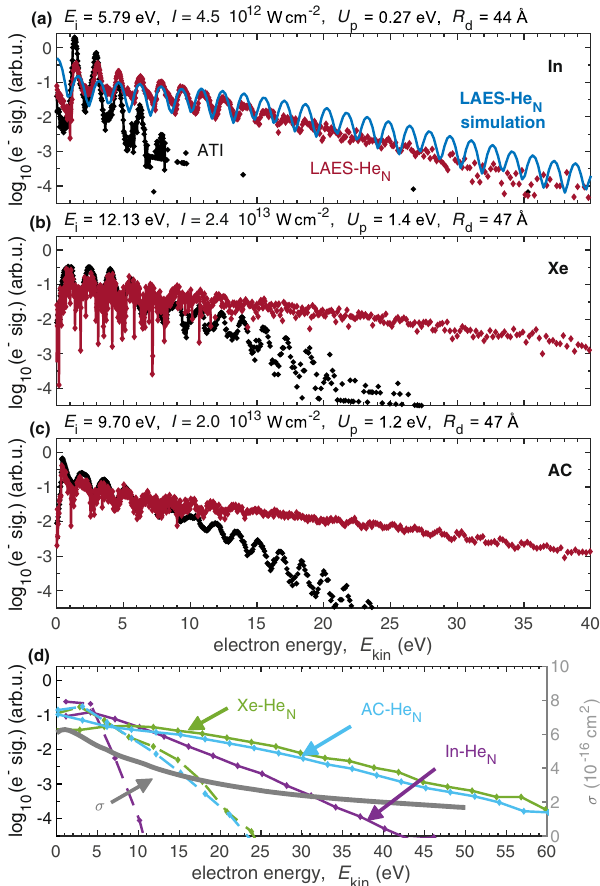
Fig. 1 Comparison of experimental electron spectra obtained by strong- fi eld ionization with 800nm light (1.55 eV photon energy) of different species in gas phase (ATI spectra, black) and inside He N (LAES spectra, red). ( a ) In atoms, ( b ) Xe atoms, ( c ) acetone (AC) molecules. The spectra are area-normalized in order to account for the reduced ionization energy inside a He N 33 . Above each plot the values of the ionization energy, E i , laser intensity, I , ponderomotive potential, U P , and droplet radius, R d , are listed. Panel ( a ) additionally shows a spectrum obtained by a Monte Carlo 3D LAES simulation. (LAES simulation, blue, area normalized). d ATI spectra (dashed lines) and LAES spectra (solid lines) as in a-c but with 3 eV binning (left ordinate), and cross section for total elastic electron scattering of electrons and He (gray line, right ordinate) 38